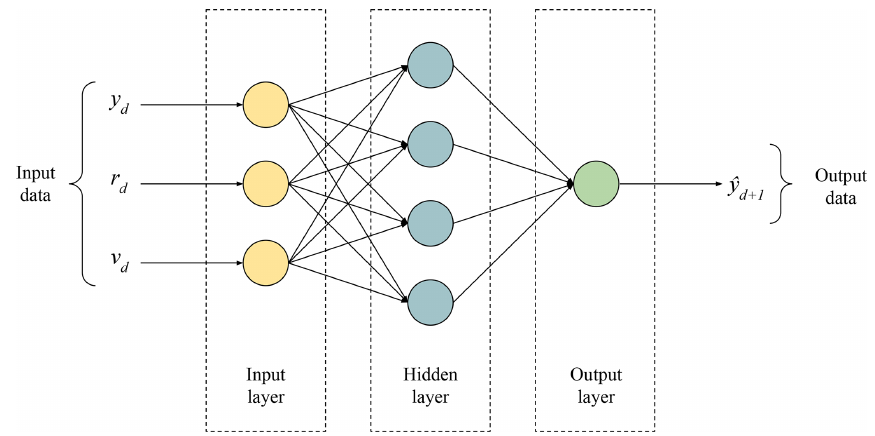
Figure 3. Architecture of a multilayer perceptron with three inputs, a hidden layer with four neurons and a single output. The input vari- ables, y d , r d and v d , are the measured outflow, inflow and volume percent for day d ; meanwhile the output variable ˆ y d + 1 is the forecasted outflow for day d +